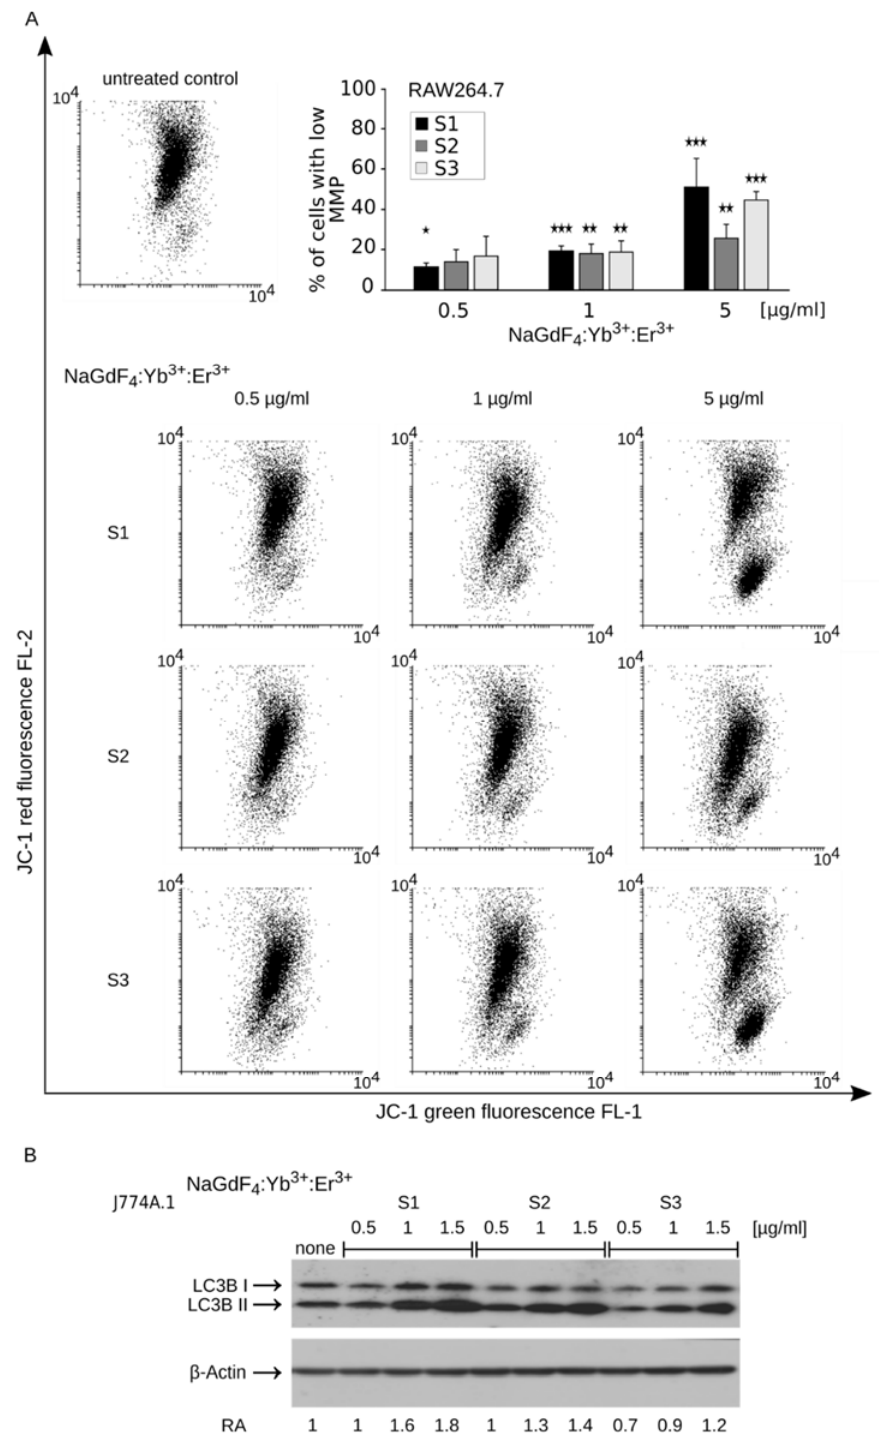
Figure 6. ( A ) The dot ‐ plot analysis of the mitochondrial potential (MMP) measured using the JC ‐ 1 mitochondrial probe in RAW264.7 cells. Representative dot plots of RAW264.7 cells treated with NPs for 24 h. Bar graph shows numerical values ( n = 3). The average percentage of cells with lowered mitochondrial ± SD are shown. * p < 0.05; ** p < 0.01; *** p < 0.001. All comparisons were performed with respect to the control; ( B ) Western blot analysis of J774A.1 cells treated with indicated concentrations of NaGdF 4 ‐ based NPs for 24 h. Increased expression of the LC3B ‐ II form can be observed as a result of treatment with NPs of all sizes. LC3B ‐ II protein expression normalized in relation to β‐ Actin (RA), ( n = 3).